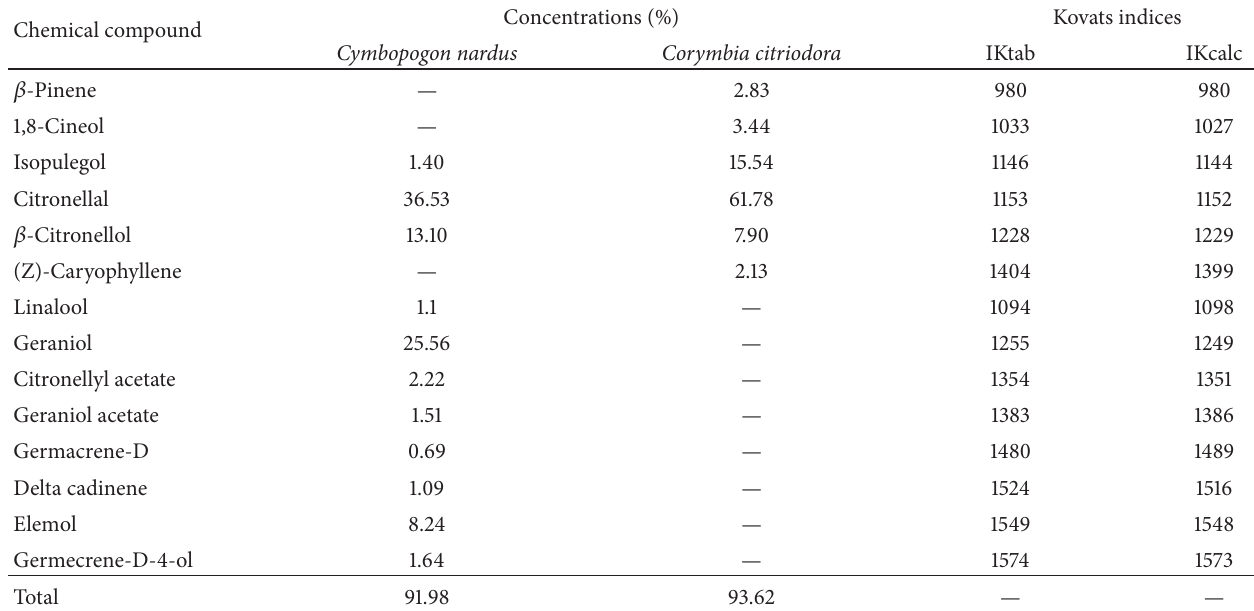
Table 1: Chemical composition, concentrations (%), and Kovats indices (calculated and tabled) for essential oils of Cymbopogon nardus and Corymbia